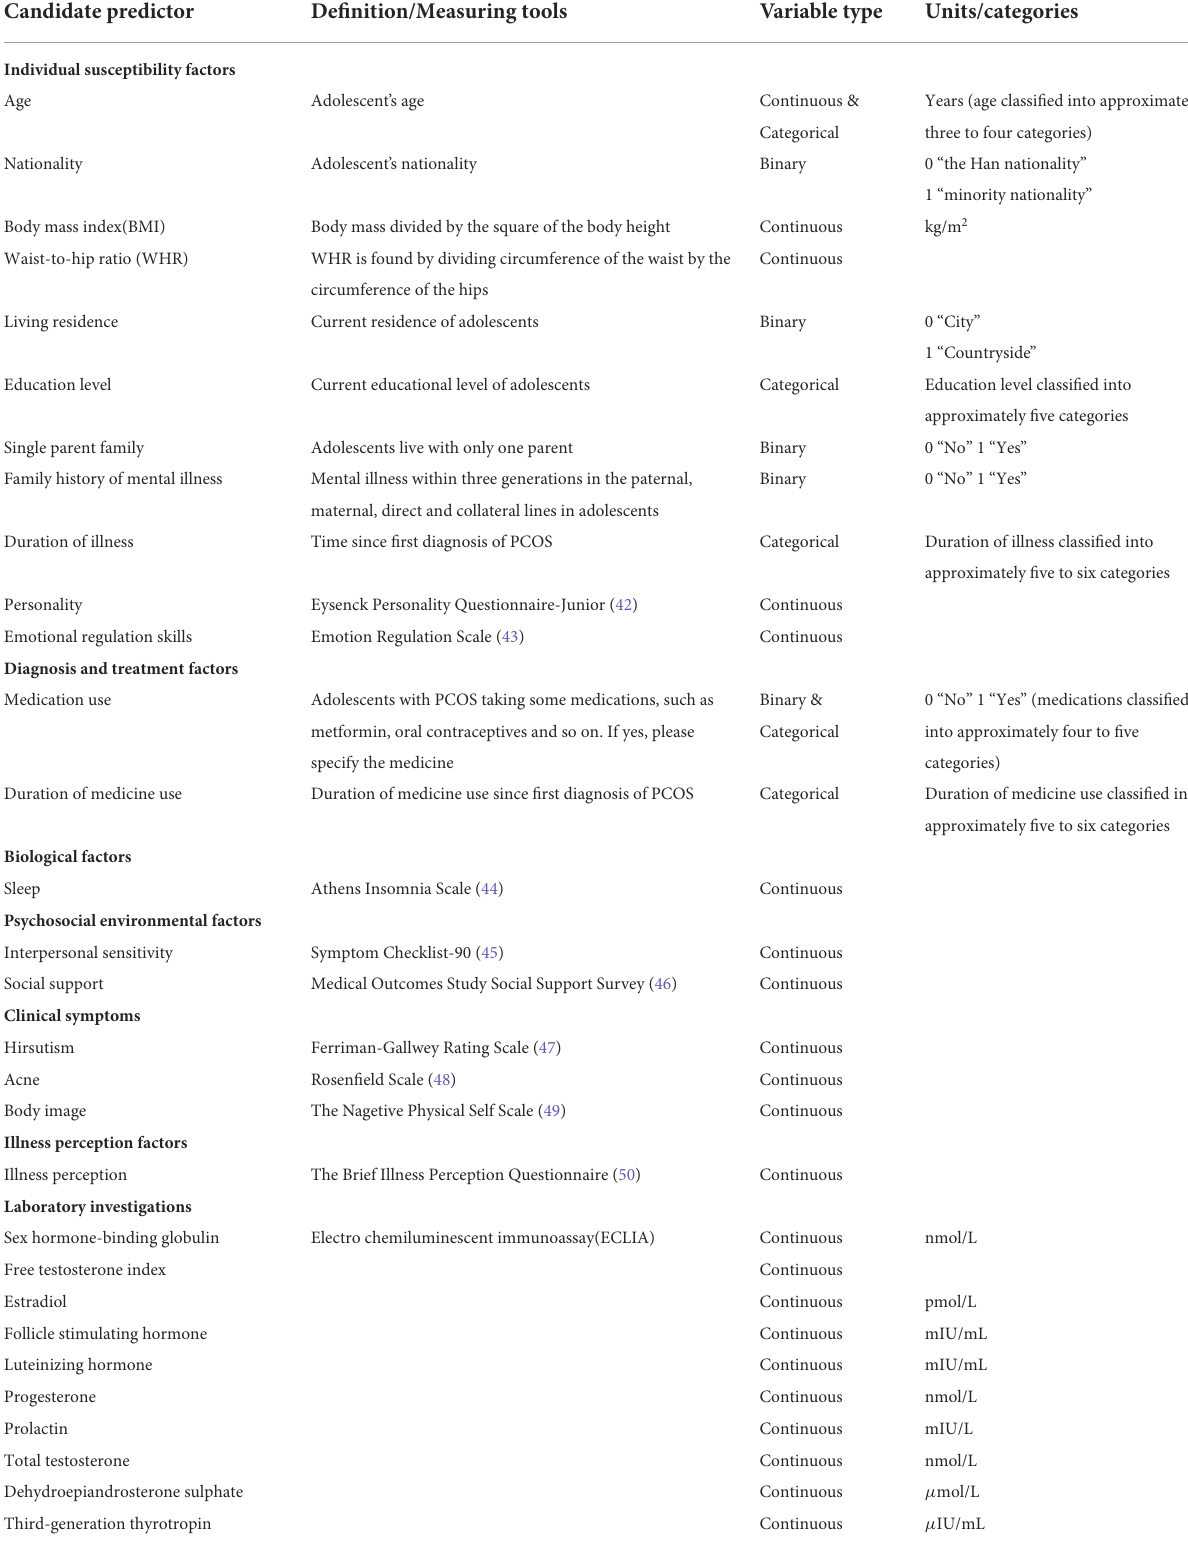
TABLE 1 Model-building predictors: definition/measuring tools, variable type and